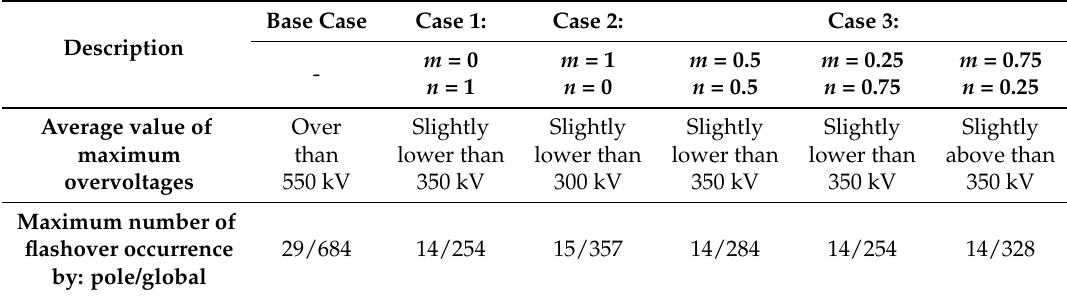
Figure 28. Comparing flashover occurrences for Case 3, with m = 0.25 and n = 0.75: base case (D0); lightning arresters at the transformer’s pole only (D1); lightning arresters at the transformer’s pole and at the six most critical poles (D7). Table 4. Summary of the simulation results obtained for the IEEE 34 bus test system when submitted to a set of scenarios of direct lightning discharges, considering D7 (arresters in the transformer and the six most critical